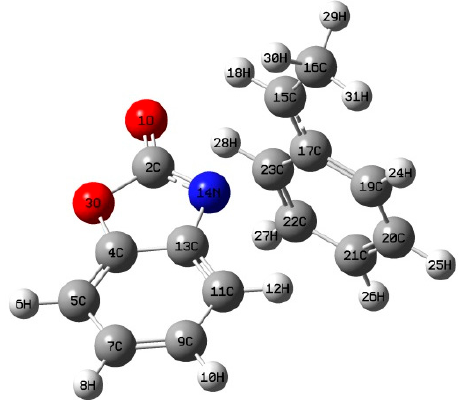
Figure 6. Transition state formed from the species Int3.